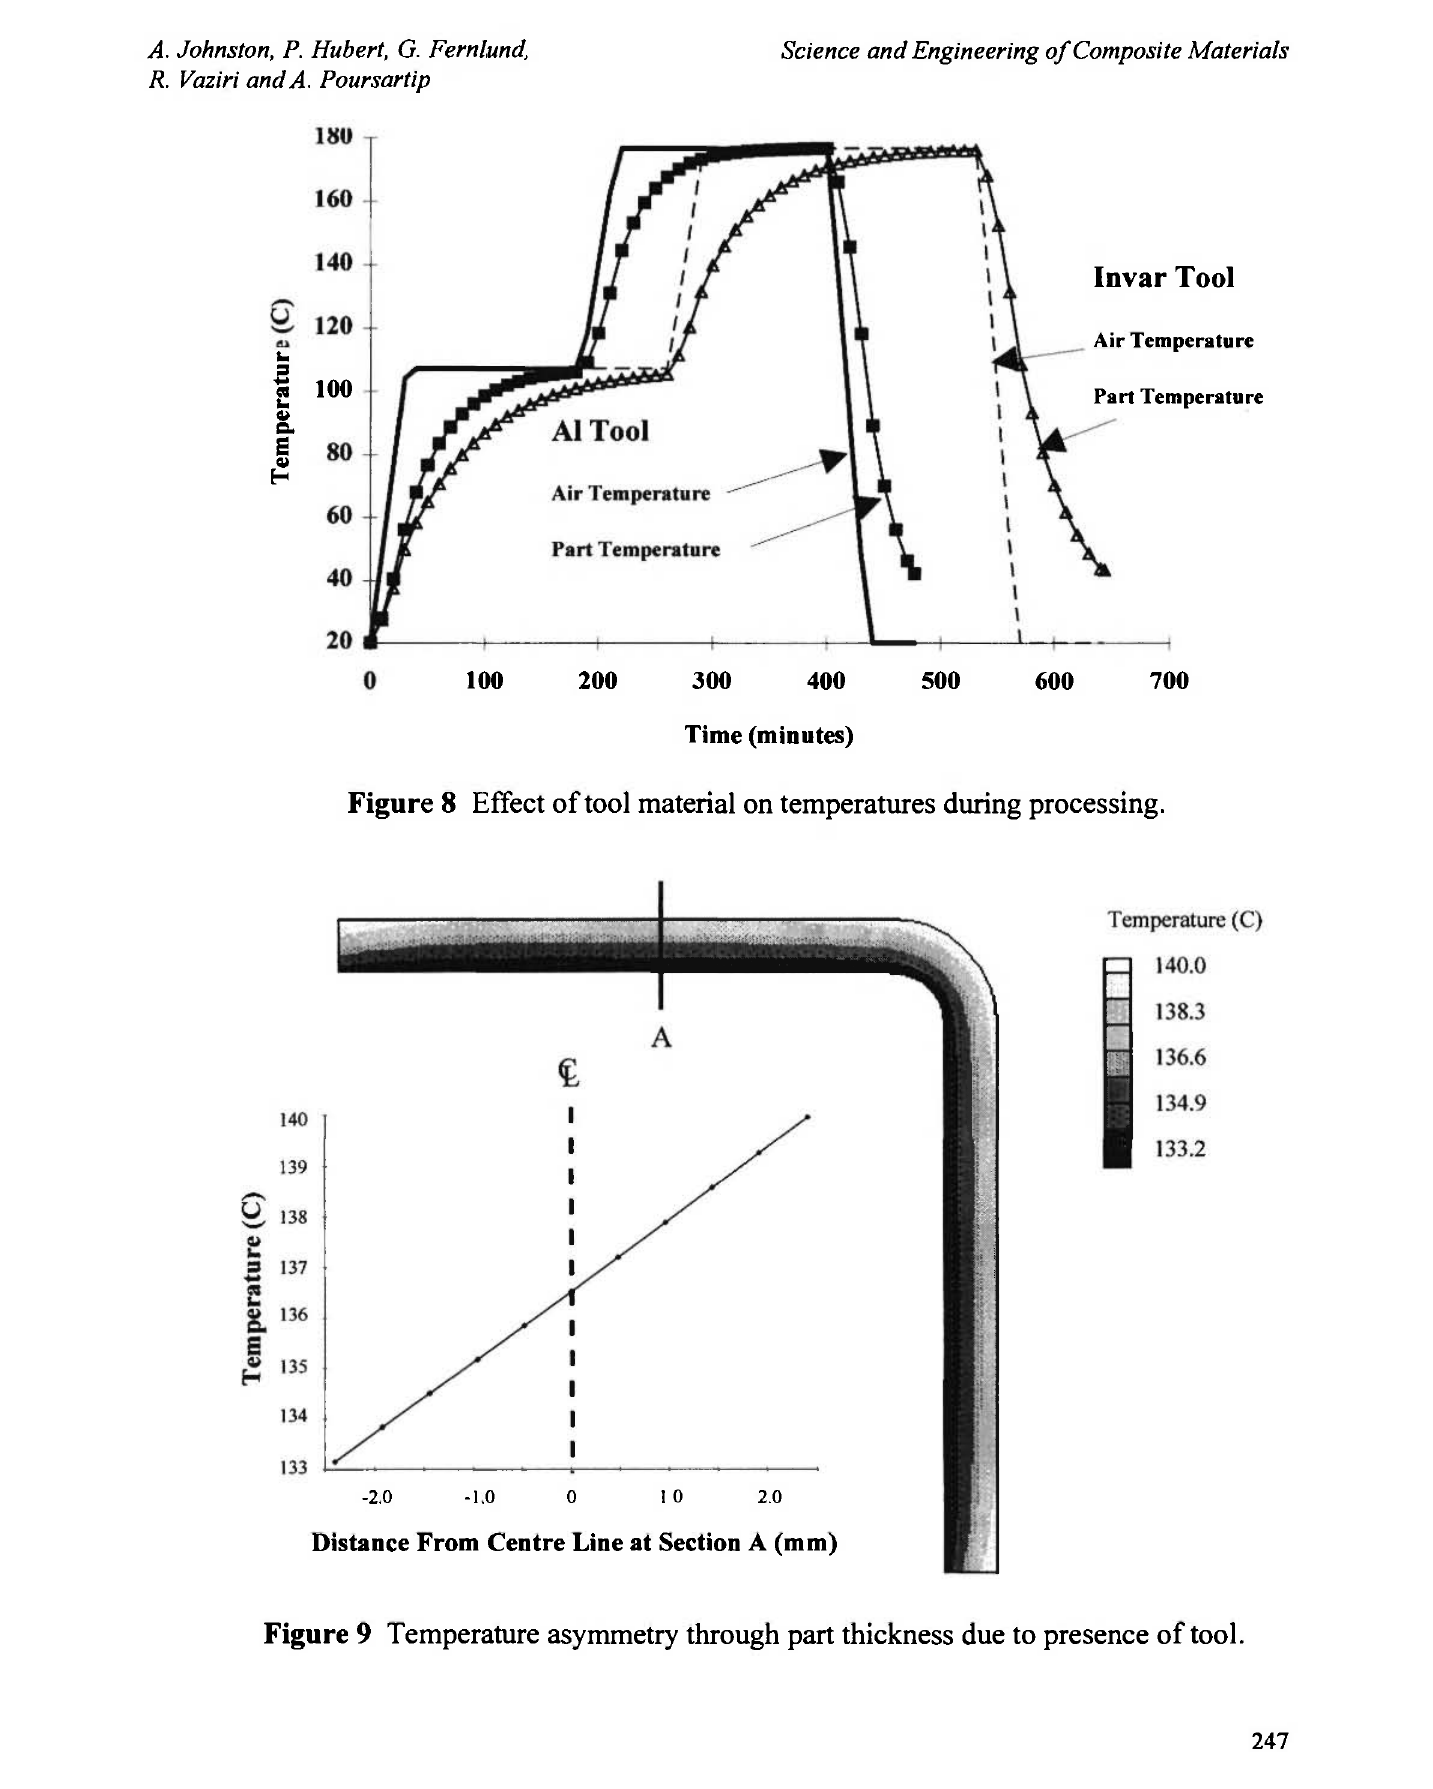
Figure 9 Temperature asymmetry through part thickness due to presence of